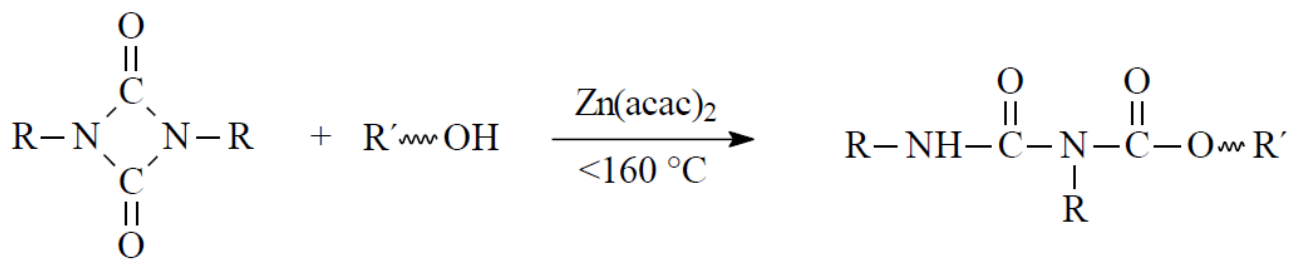
Figure 1. Crosslinking mechanism in the basic powder coating system.